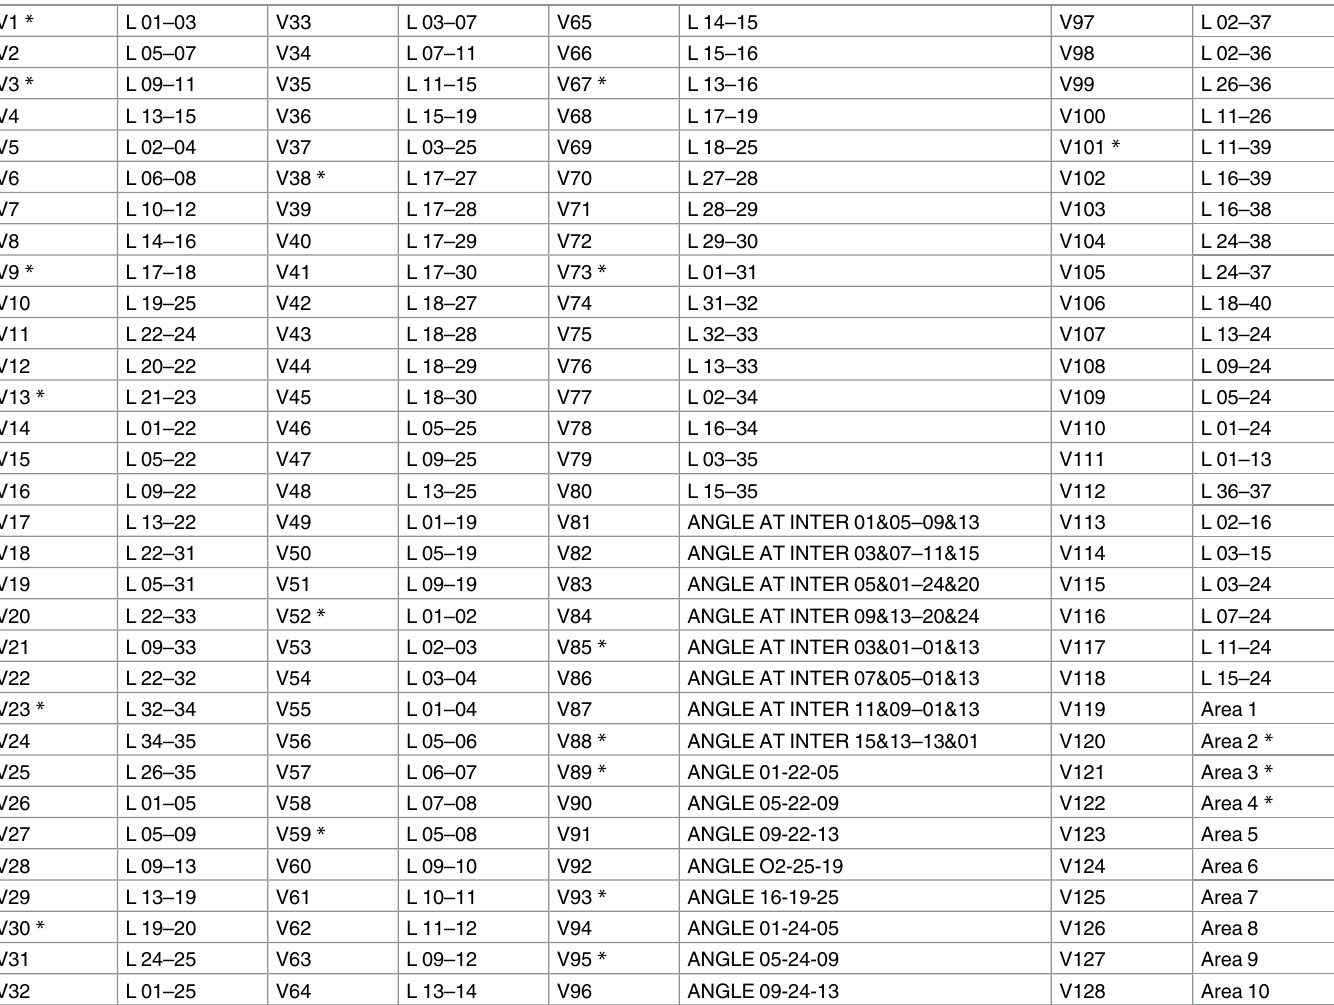
Table 1. The number of variables extractedfrom the footprint images as lengths (L), angles and